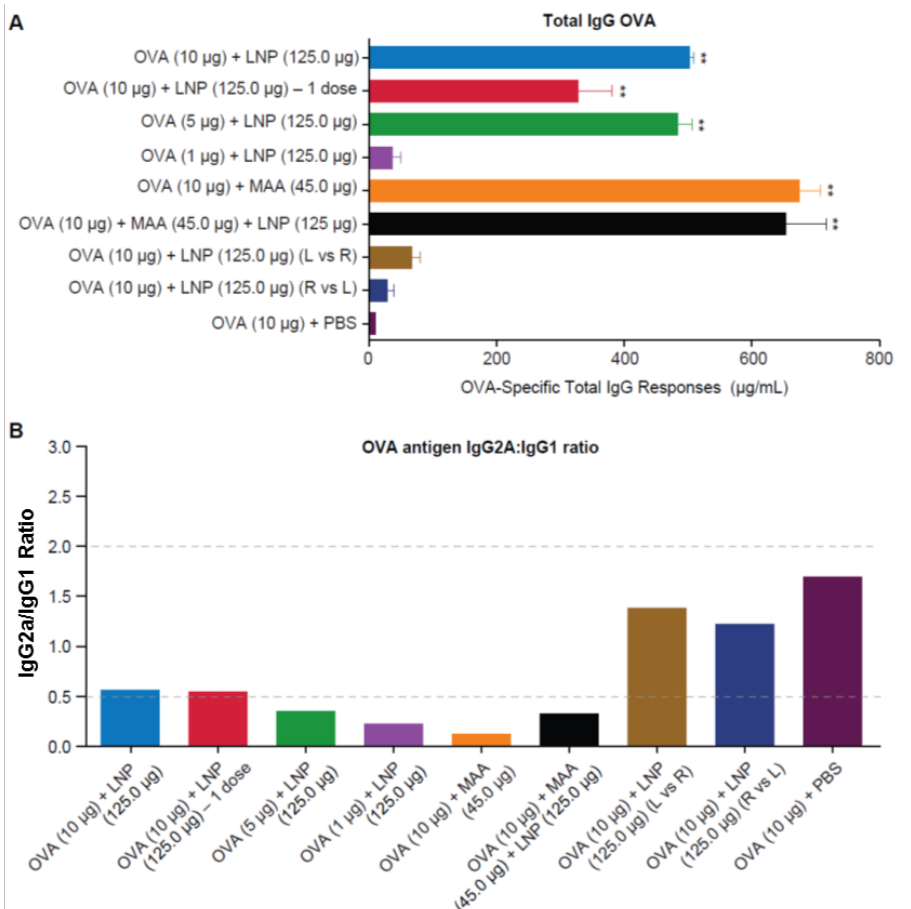
Figure 5. OVA specific total IgG responses in C57BL/6 mice. Lipid Nanoparticles must be co-administered with OVA antigen to enhance Th2 type specific B-cell responses in mice. ( A )